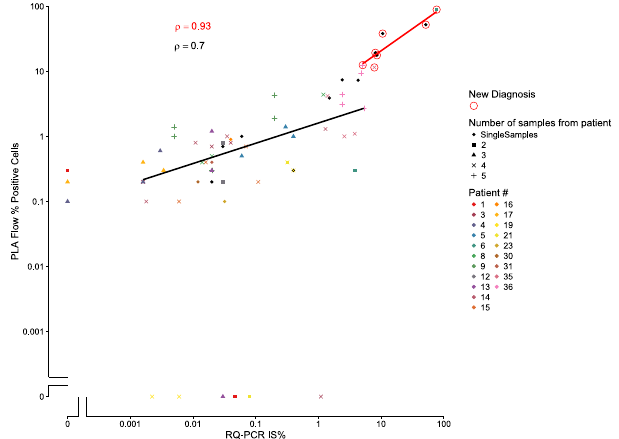
Figure 6. Correlation of BCR-ABL1 fusion protein positive cells as determined by PLA-flow and BCR-ABL1 fusion transcript levels as determined by RQ-PCR. A total of 81 samples from 36 different patients were analyzed and compared; seven samples (indicated with red circles) represented samples analyzed before initiation of therapy, whereas the remaining samples were collected at follow-up. Two correlations were performed, one for follow-up samples ( ρ = 0.7) and one for diagnostic samples ( ρ = 0.93). Patient numbers and numbers of samples investigated for each patient is indicated with different colors/symbols.